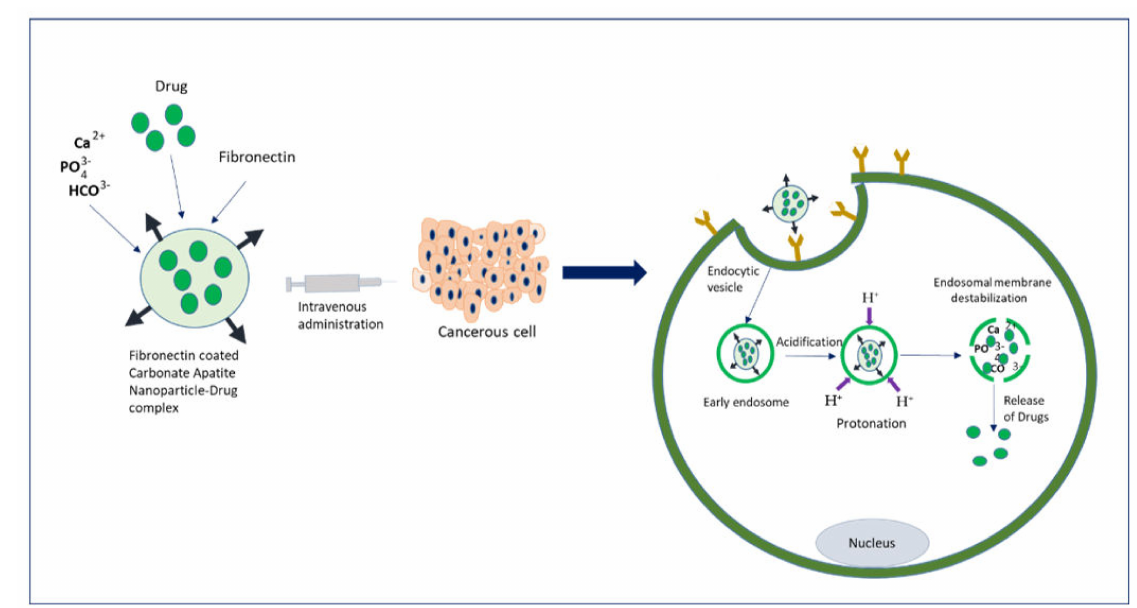
Figure 3. An overview of the drug delivery mechanism of fibronectin-coated pH-sensitive carbonate apatite (CA) NPs to the cancer cells expressing the fibronectin-specific integrin: upon systemic administration, drug-NP complexes are internalized into the target cell through specific integrin-mediated endocytosis. The acidic environment of an early endosome causes dissolution of the endocytosed NPs, resulting in their dissolution and release of the drugs, an event that might lead to endosomal membrane destabilization through accumulated ion-induced osmotic pressure, triggering quick release of drugs into the